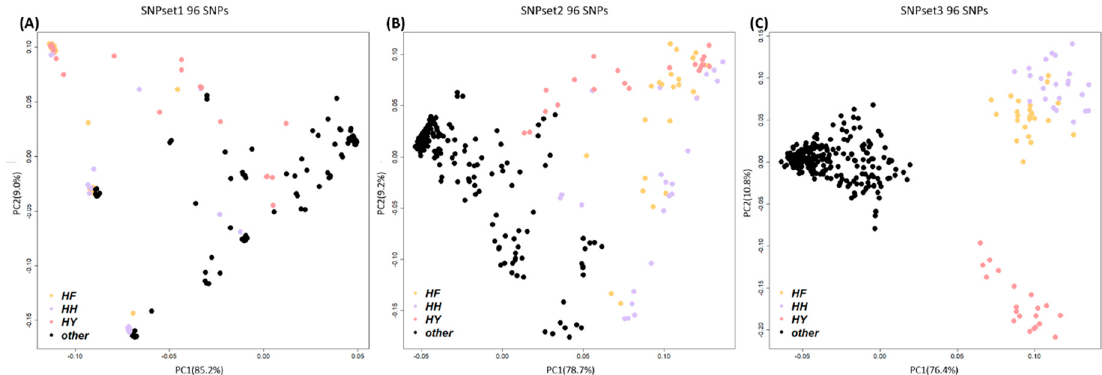
Figure 5. The optimal marker combination used to distinguish the case group (HH, HF, and HY) from the other chicken groups, considering population linkage disequilibrium (LD). ( A ) SNPset1 result using 96 SNP markers with high p -values produced in the association analysis, without considering the LD in the chicken population. ( B ) SNPset2 result using 96 SNPs that had undergone 1-LD pruning. ( C ) SNPset3 result using 96 SNPs that had undergone 50-LD pruning. The best marker combination for distinguishing between the case and control groups was SNPset3. HH, Hanhyup H; HF, Hanhyup F; HY, Hanhyup Y; other, all other chicken populations.